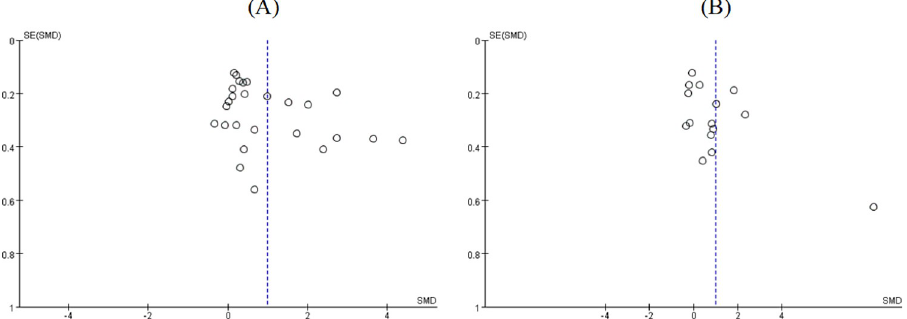
Fig 3. Funnel plots for (A) sexual function; (B) sexual